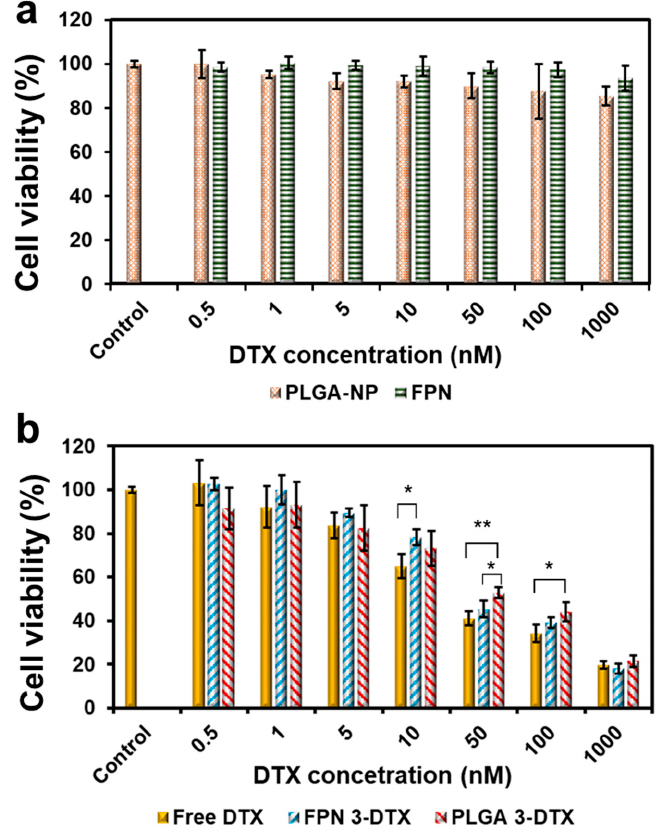
Figure 8. Cell viability of MDA-MB-231 breast cancer cells treated with ( a ) drug-loaded nanoparticles (FPN 3-DTX and PLGA 3-DTX) and free DTX. ( b ) blank nanoparticles (FPN and PLGA) in which the concentration of nanoparticles was equal to drug-loaded nanoparticles after 72 h treatment. Results are expressed as the mean ± SD of three replicates for each treatment (n = 3). Marked asterisks (*) with * p < 0.05 and ** p < 0.01 represent statistically significant di ff